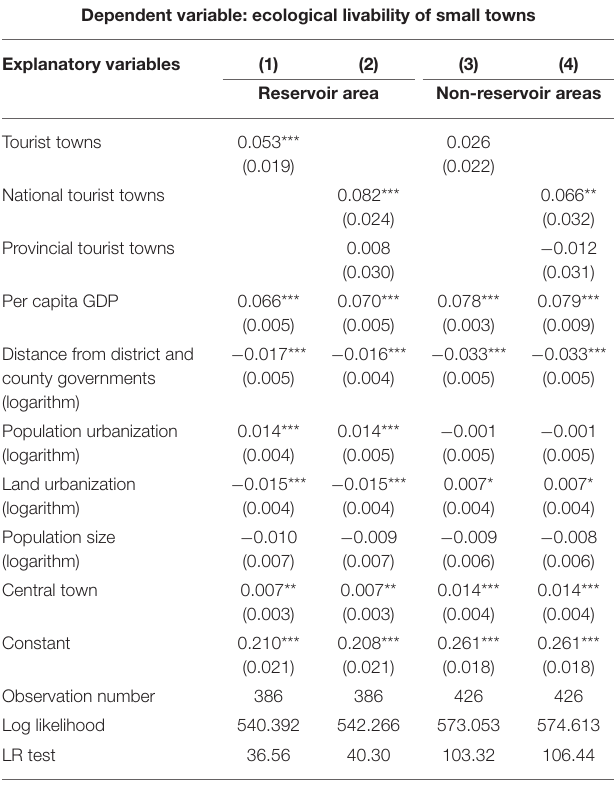
TABLE 8 | Results based on the division of reservoir and non-reservoir areas. Dependent variable: ecological livability of small